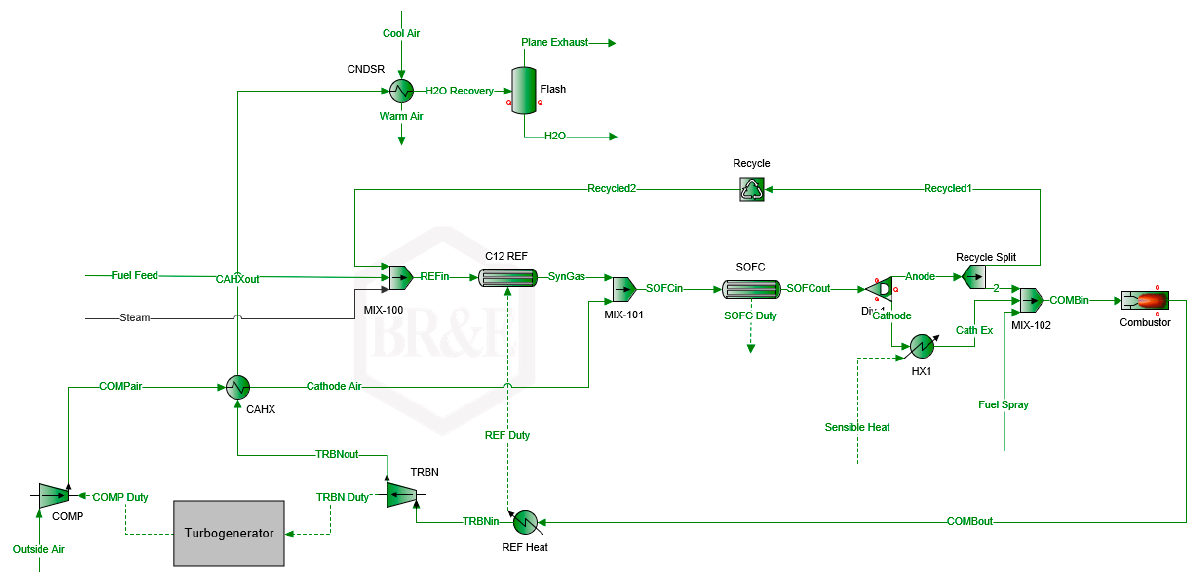
Figure 2. SOFC-GT system flowsheet in ProMax.